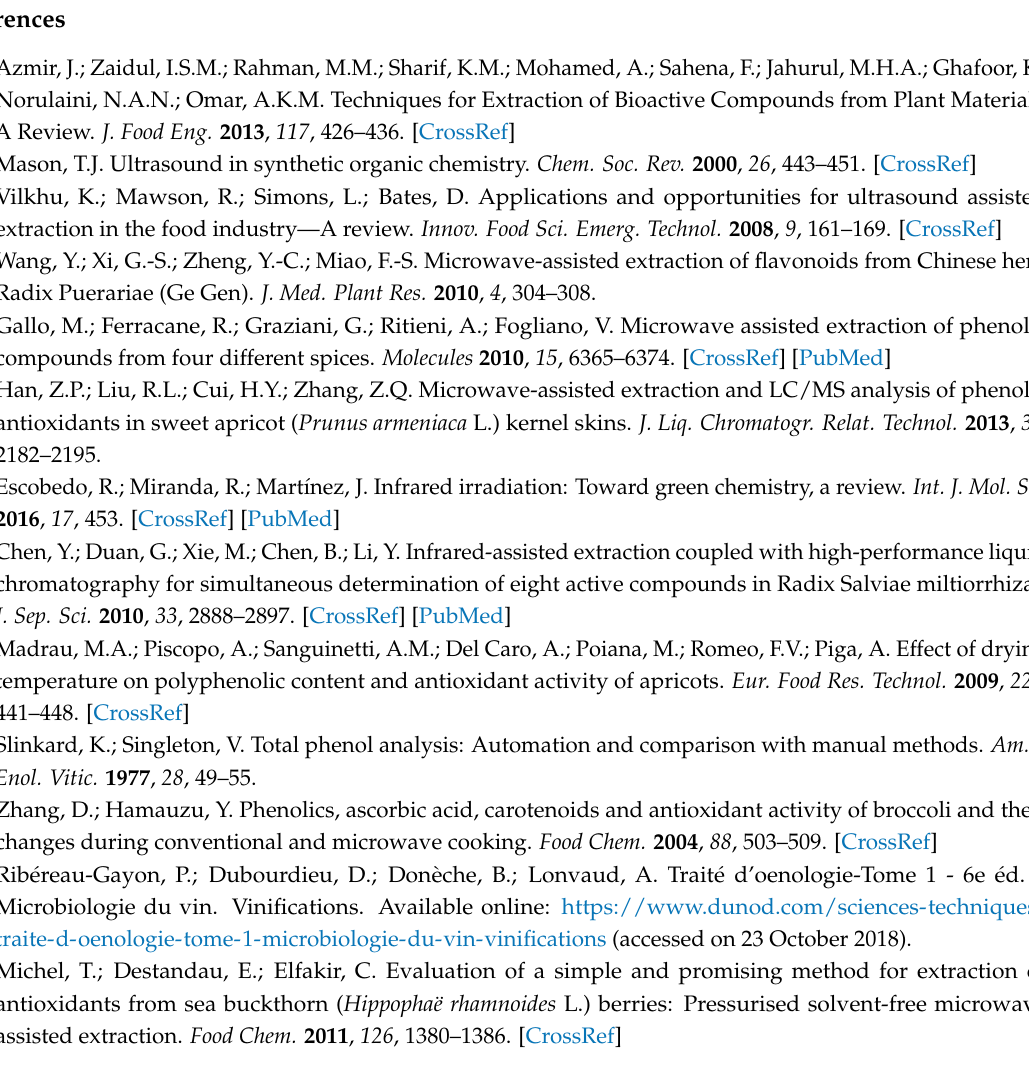
Figure S1: Chromatographic profile of the several phenolic